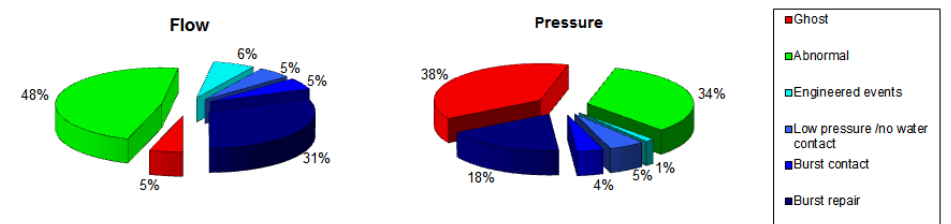
Figure 3. 3-month summary of AI flow and pressure alerts (January to